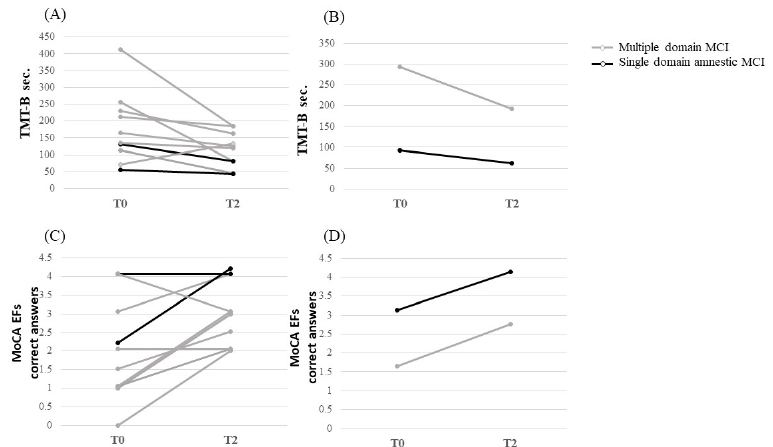
Figure 4. Ten days of transcranial magnetic stimulation effect on executive functions in multiple domain and single domain, amnestic MCI. ( A ) Executive functions assessed with the trial making test—part B (TMT-B) by patient; ( B ) executive functions assessed with the TMT-B by patients with multiple domain and single domain, amnestic MCI; ( C ) executive functions assessed with the Montreal cognitive assessment (MoCA) subtasks by patient; ( D ) executive functions assessed with MoCA subtasks by patients with multiple domain and single domain, amnestic MCI. Abbrevia- tions: TMT-B = trial making test—part B; MoCA EFs = Montreal cognitive assessment executive function